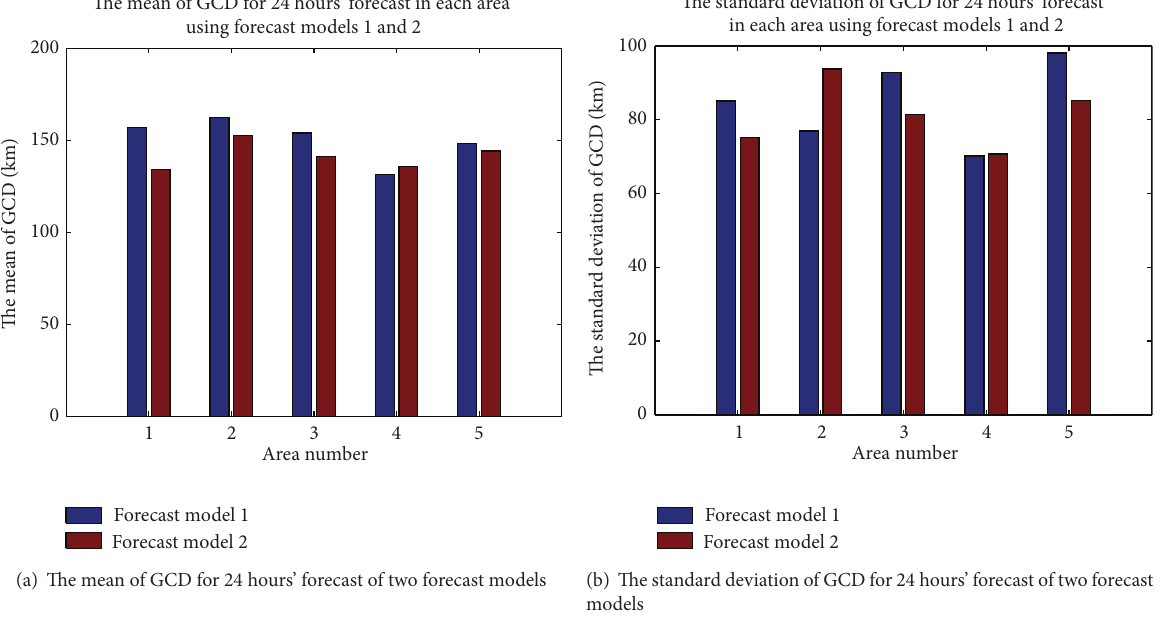
Figure 15: The mean/standard deviation of GCD for 24 hours’ forecast of two forecast models. The standard deviation of GCD for 48 hours’ forecast in each area using forecast models 1 and 2